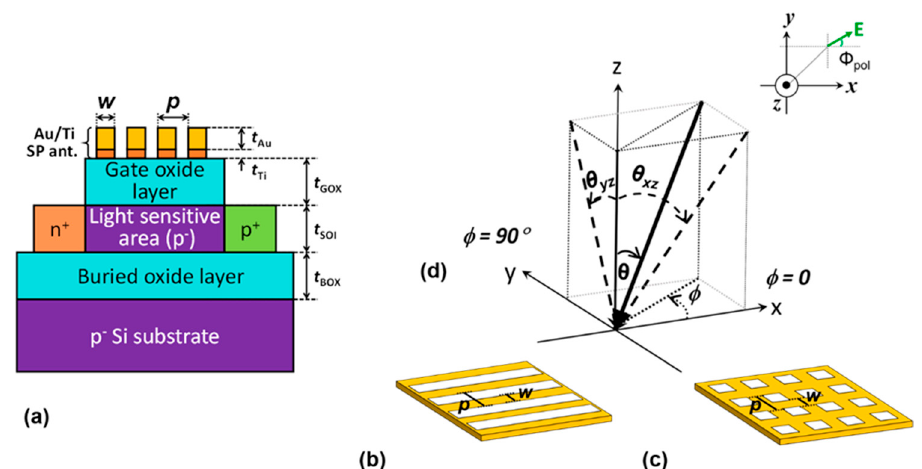
Figure 1. ( a ) Cross-sectional view of the silicon-on-insulator (SOI) photodiode (PD) with a surface plasmon (SP) antenna; ( b ) 1D line and space grating; ( c ) 2D hole array grating; ( d ) definitions of azimuth ( φ ), elevation ( θ ) , and polarization ( φ pol ) angles of the incident light reproduced from [22]. The projected elevation angles θ xz and θ yz to x - z and y - z planes, respectively, are also clarified for theoretical discussions.